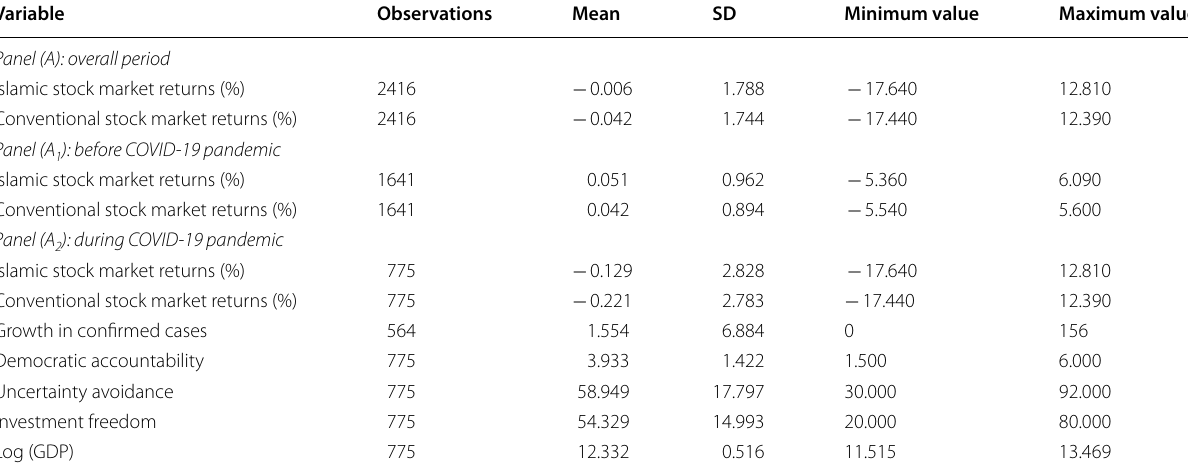
Table 2 Descriptive statistics of main variables